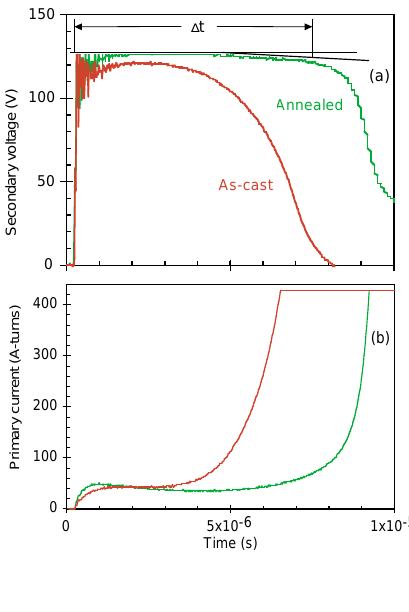
FIG. 2. (Color) Comparison of the (a) secondary voltage and (b) primary drive current before and after annealing of a MET- GLAS 2605 SC amorphous metal core that has mica paper in- terlaminar insulation. The usable flux swing, as indicated in (a) by D t and discussed in the text, increases